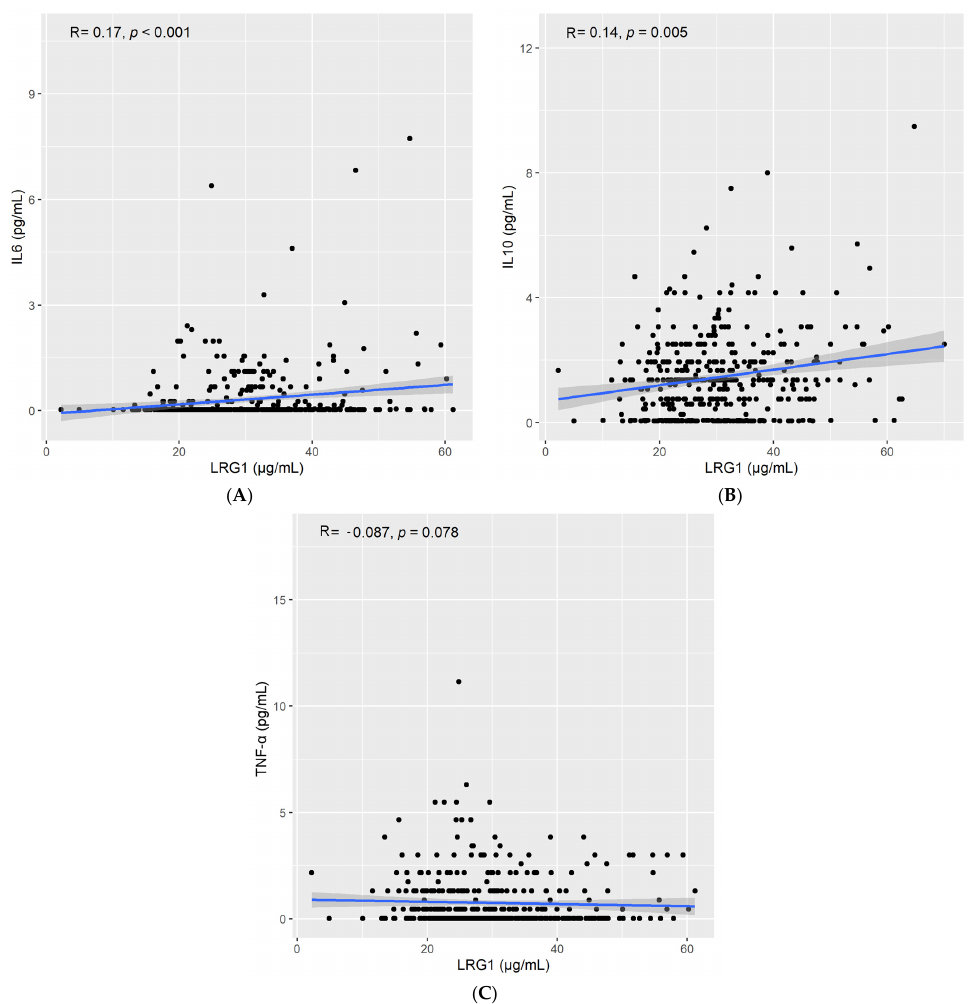
Figure 3. Correlation between LRG1 and ( A ) IL6, ( B ) IL10, and ( C ) TNF- α .